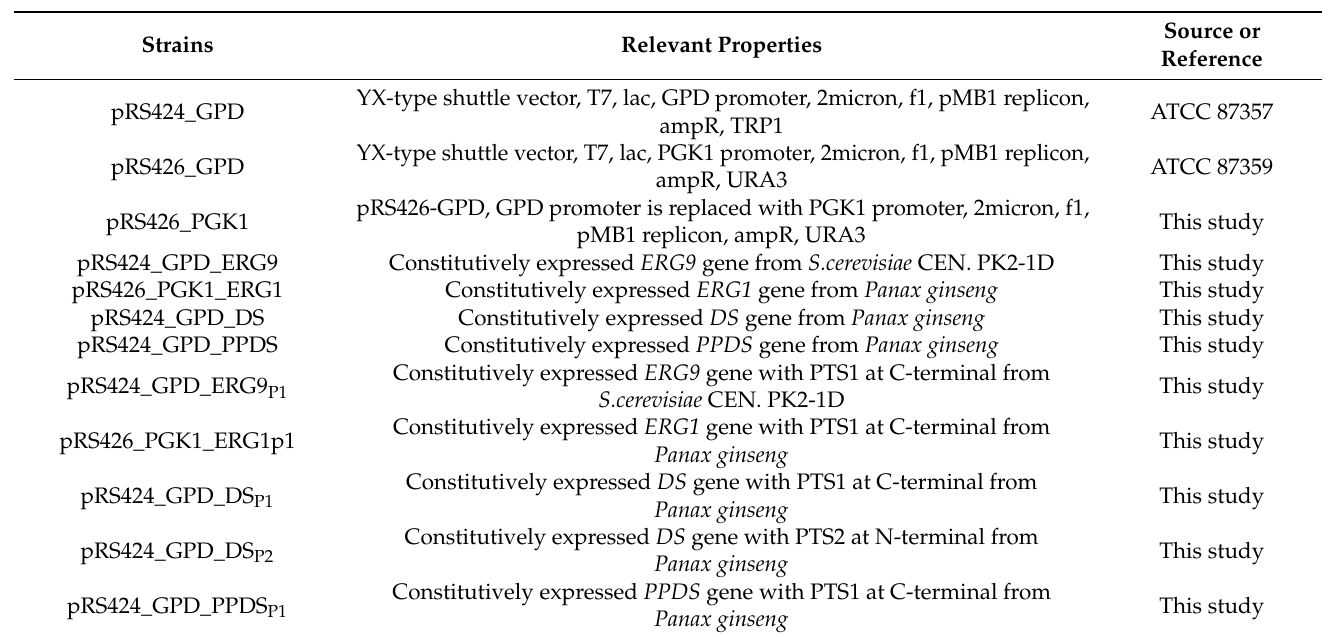
Table 2. Plasmids used in this